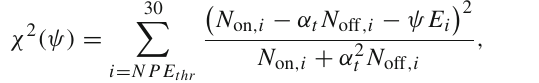
models in Fig. 25 based on Joo’s and Xu’s measurements, and a 1-year reactor-on period and 100-days reactor-off period with 100% live time and 100% event selection efficiency.